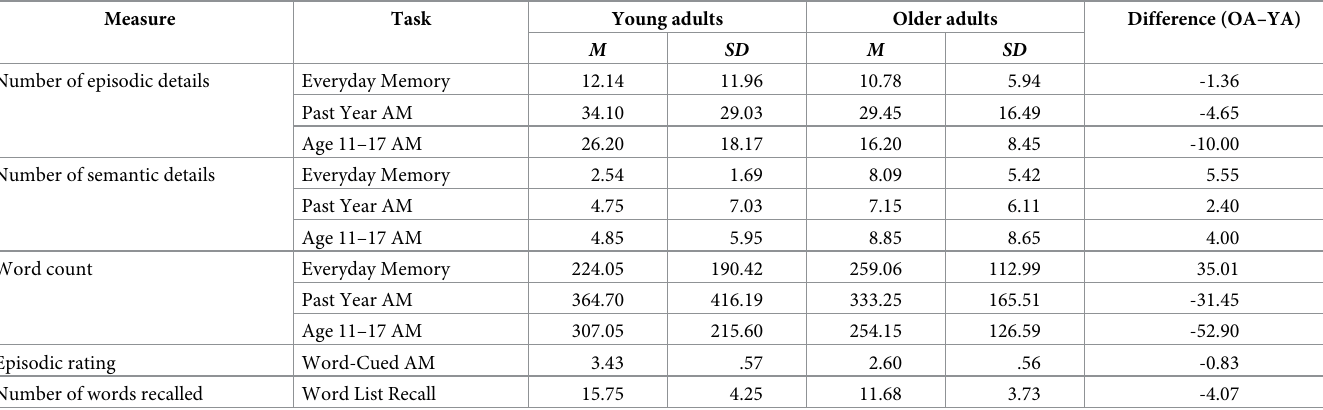
Table 5. Raw scores on each of the memory measures.